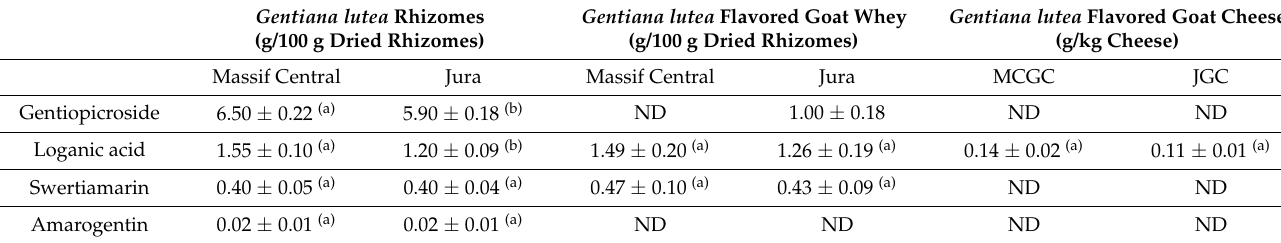
Table 2. Mean values and standard deviations of contents of seco-iridoids expressed in g/100 g of dried gentian rhizomes for Gentiana lutea rhizomes and gentian flavored goat whey and in g/kg for gentian flavored goat cheeses. ND means the compound is no more detected under our chromato- graphic conditions. Values with a common superscript are not significantly different ( p <